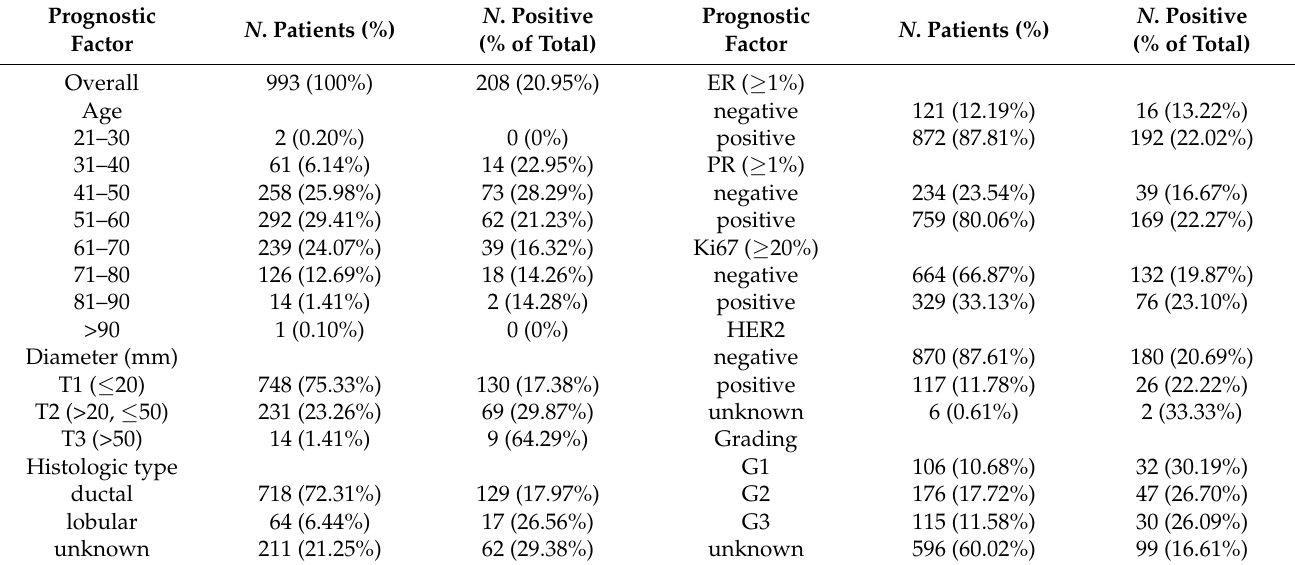
Table 1. Absolute (percentage) distribution of patients with positive lymph nodes according to considered prognostic factors.